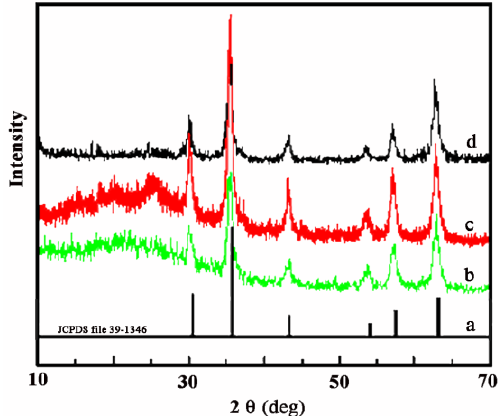
Figure 11. XRD patterns of samples: a, standard spectrum of γ-Fe 2 O 3 ; b, γ-Fe 2 O 3 ; c, γ-Fe 2 O 3 /PANI and d, γ-Fe 2 O 3